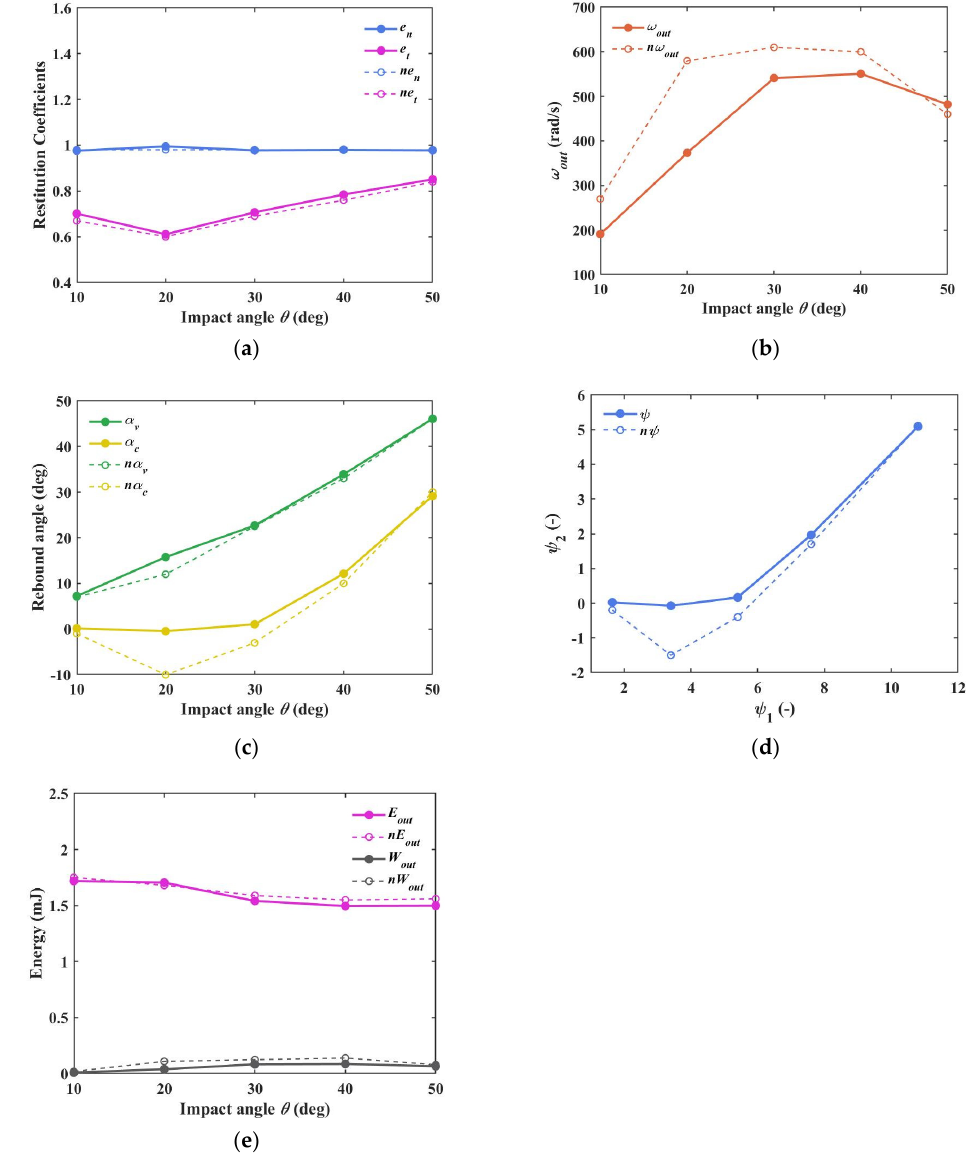
Figure 4. Comparison between the experiment and the simulation results. ( a ) restitution coefficient; ( b ) outgoing angular velocity; ( c ) rebound angle; ( d ) non-dimensional angle; ( e ) energy.